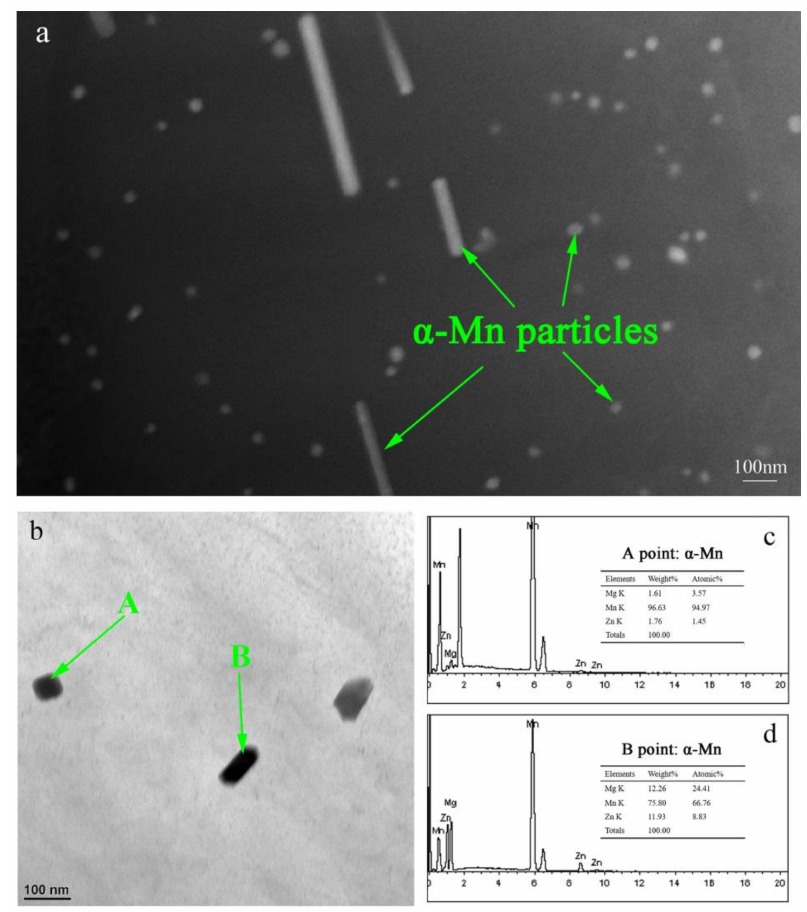
Figure 9. ( a )HAADF-STEM and ( b )Bright-TEM (transmission electrical microscope) images of the solution-treated ZM51 alloy tube, and ( c , d ) corresponding EDS results of the points indicated in